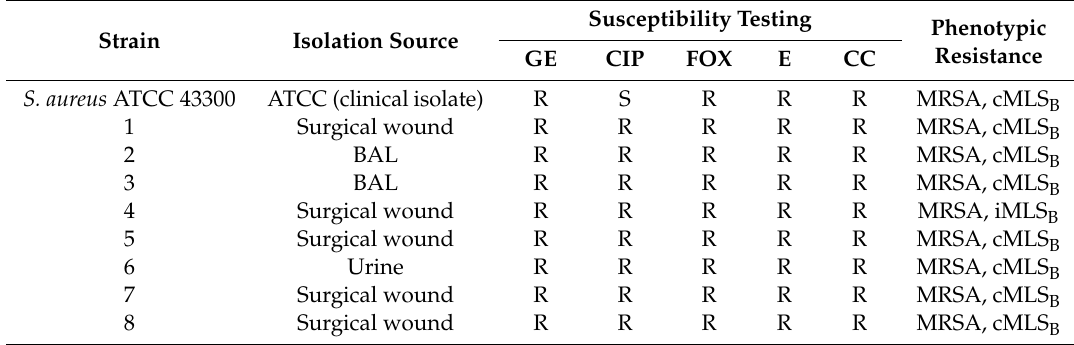
Table 1. Characteristics of Staphylococcus aureus strains.